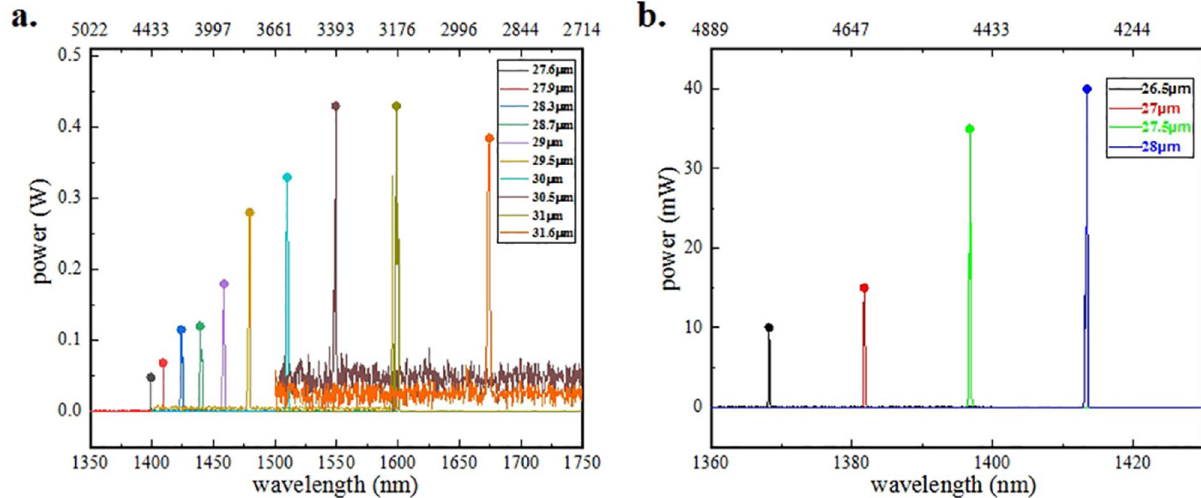
Figure 2. Signal wavelength of different channels. Label of bottom axis means wavelength of signal while top line is corresponding calculated wavelength of idler and the Y-axis is power of idler. ( a ) Shows spectra of PPLN with long period at temperature of 40 °C. ( b ) Shows spectra of PPLN with shorter period at temperature of 45 °C. (Origin 2018, https ://www.origi nlab.com/, Adobe Photoshop CC 2018, https ://www.adobe .com/cn/produ cts/photo shop.html/).